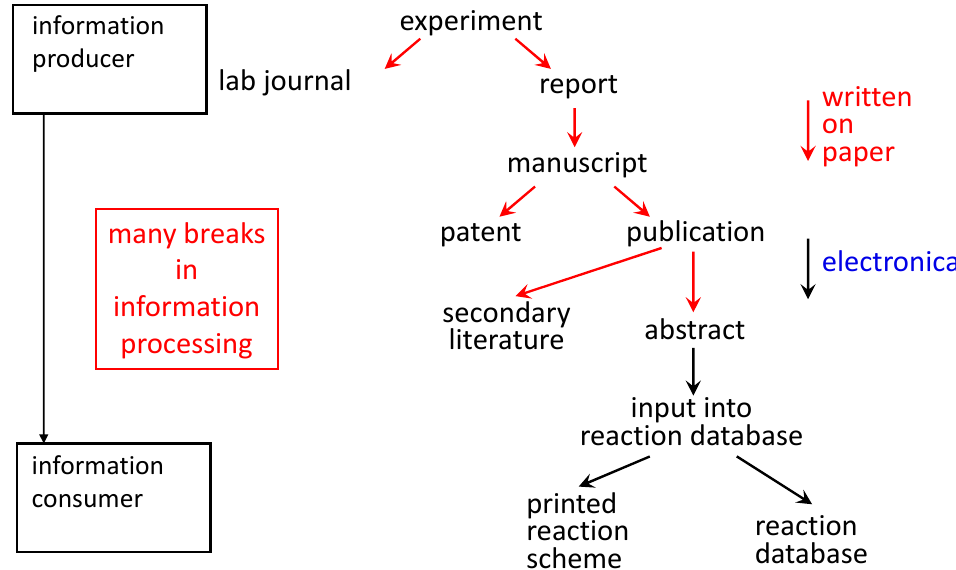
Figure 2. At present, the path of information from the experiment to end up in a database involves many steps of manual intervention where the information is newly